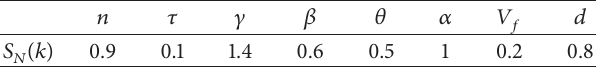
Table 5: The sensitivity coefficients of parameters on the 𝑁